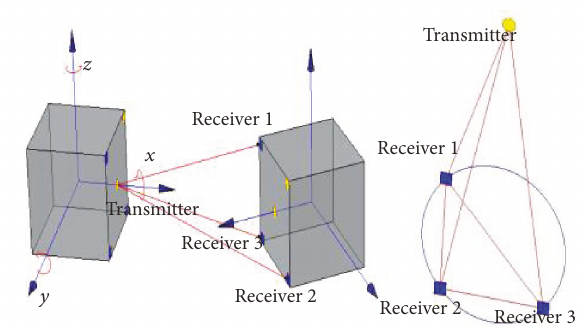
Figure 1: Multiple transmitting and receiving antenna con fi